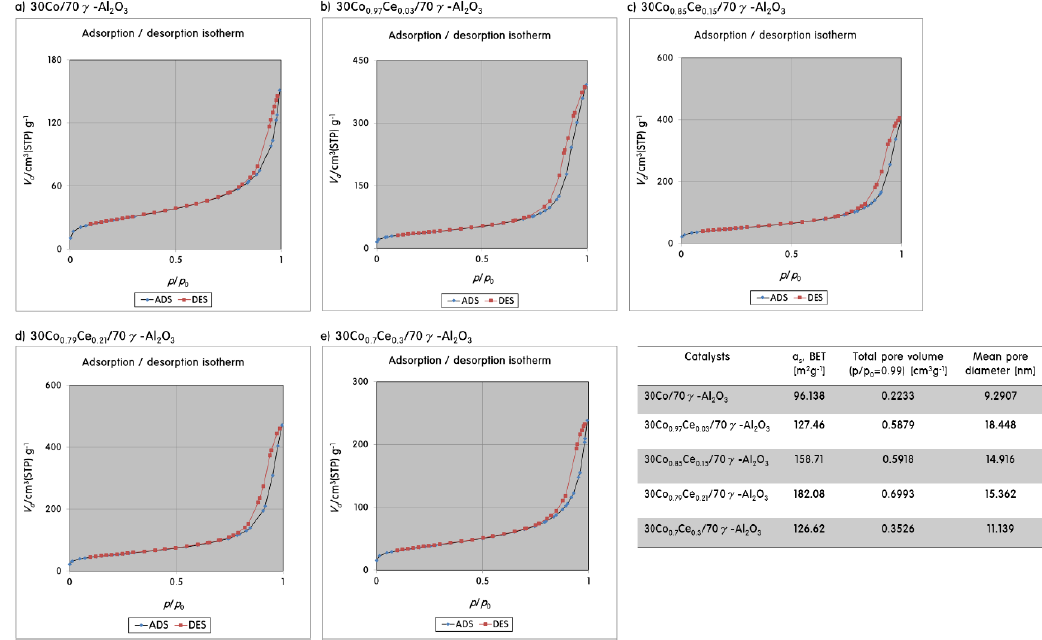
Figure 3. N 2 adsorption/desorption isotherm curves at 77 K for the fresh 30Co x Ce y /70γ-Al 2 O 3 catalysts.